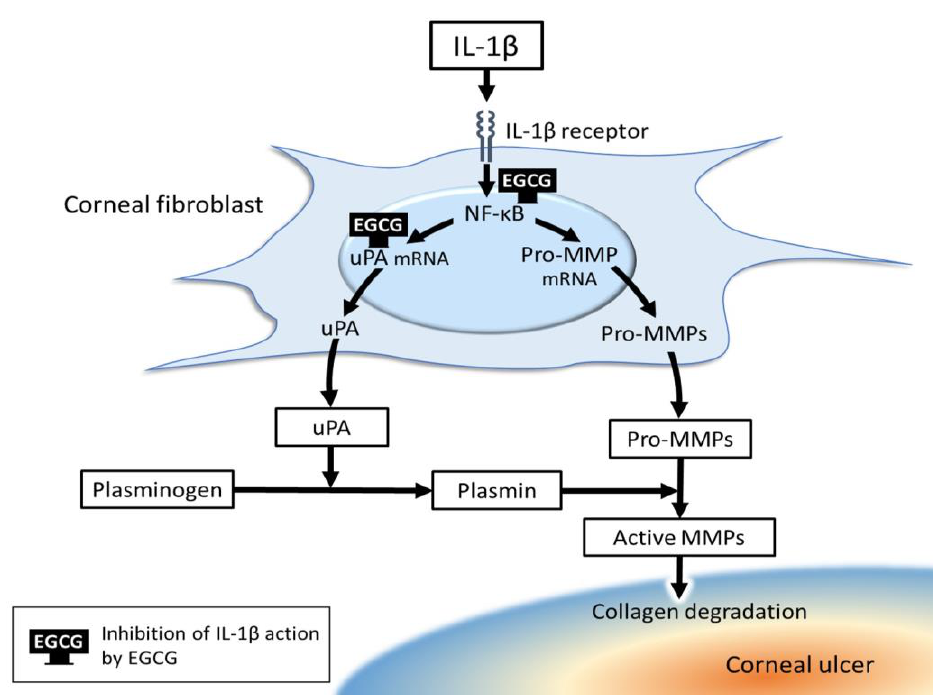
Figure 3. Possible mechanism for the inhibition by epigallocatechin-3-gallate (EGCG) of IL-1β-induced collagen degradation by corneal fibroblasts.